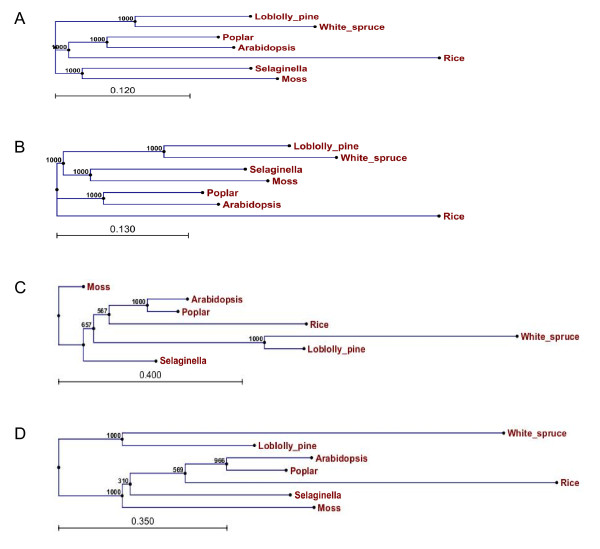
Phylogenetic trees for ancestral xylem orthologs in land plants. Deduced amino acid or protein sequences of 501 ancestral xylem orthologs from 7 species were combined to build consensus trees using three alignment methods, including Kalign (A), ClustalX2 and Mafft (B) with a bootstrap of 1,000. Individual trees were also generated for each gene using CLC Genomic Workbench 3 (CLC bio, Denmark). Genes with phylogenetic trees paralleled the trend of plant evolution (235, 47%) were present in an example (C) while genes that diverged from plant evolution (266, 53%) had diverse patterns of molecular evolution. A representative phylogenetic tree of genes (158, 32%) with conserved branches between angiosperms and ancient plant species but divergent branches to gymnosperms is showed in example (D).